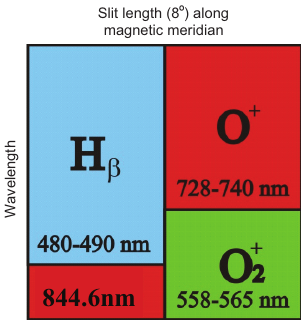
Fig. 1. Filter mosaic of the SIF spectrograph. Marked on each filter is the wavelength range the filter transmits and the main auroral emission species in this